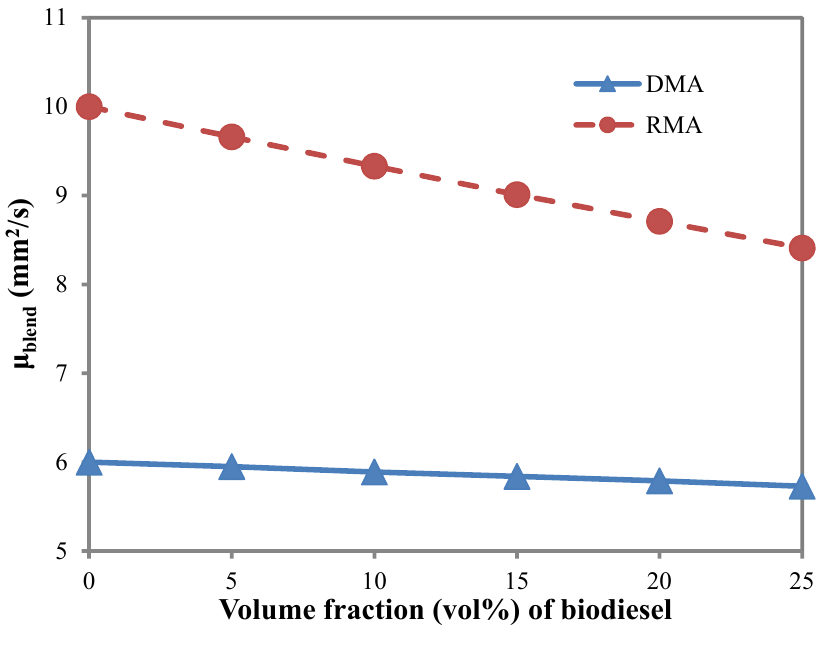
Figure 3. Variation of kinematic viscosity with volume fraction of biodiesel blends in distillate marine fuel DMA and residual marine fuel